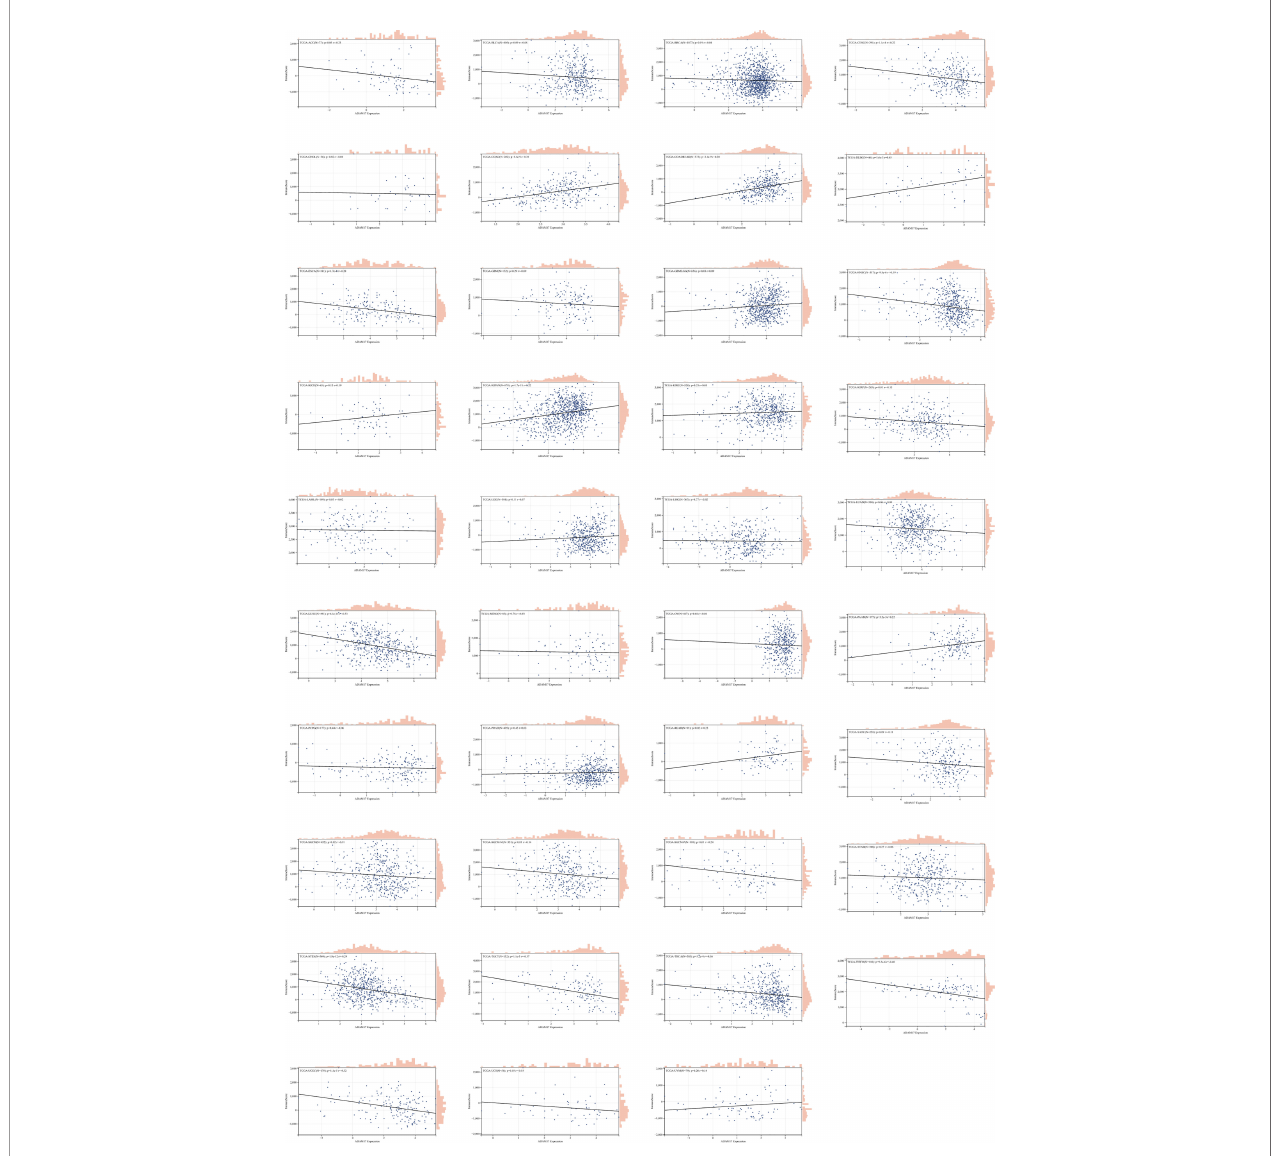
FIGURE 5 | The correlation between ADAM17 expression and immune invasion score in multiple cancer